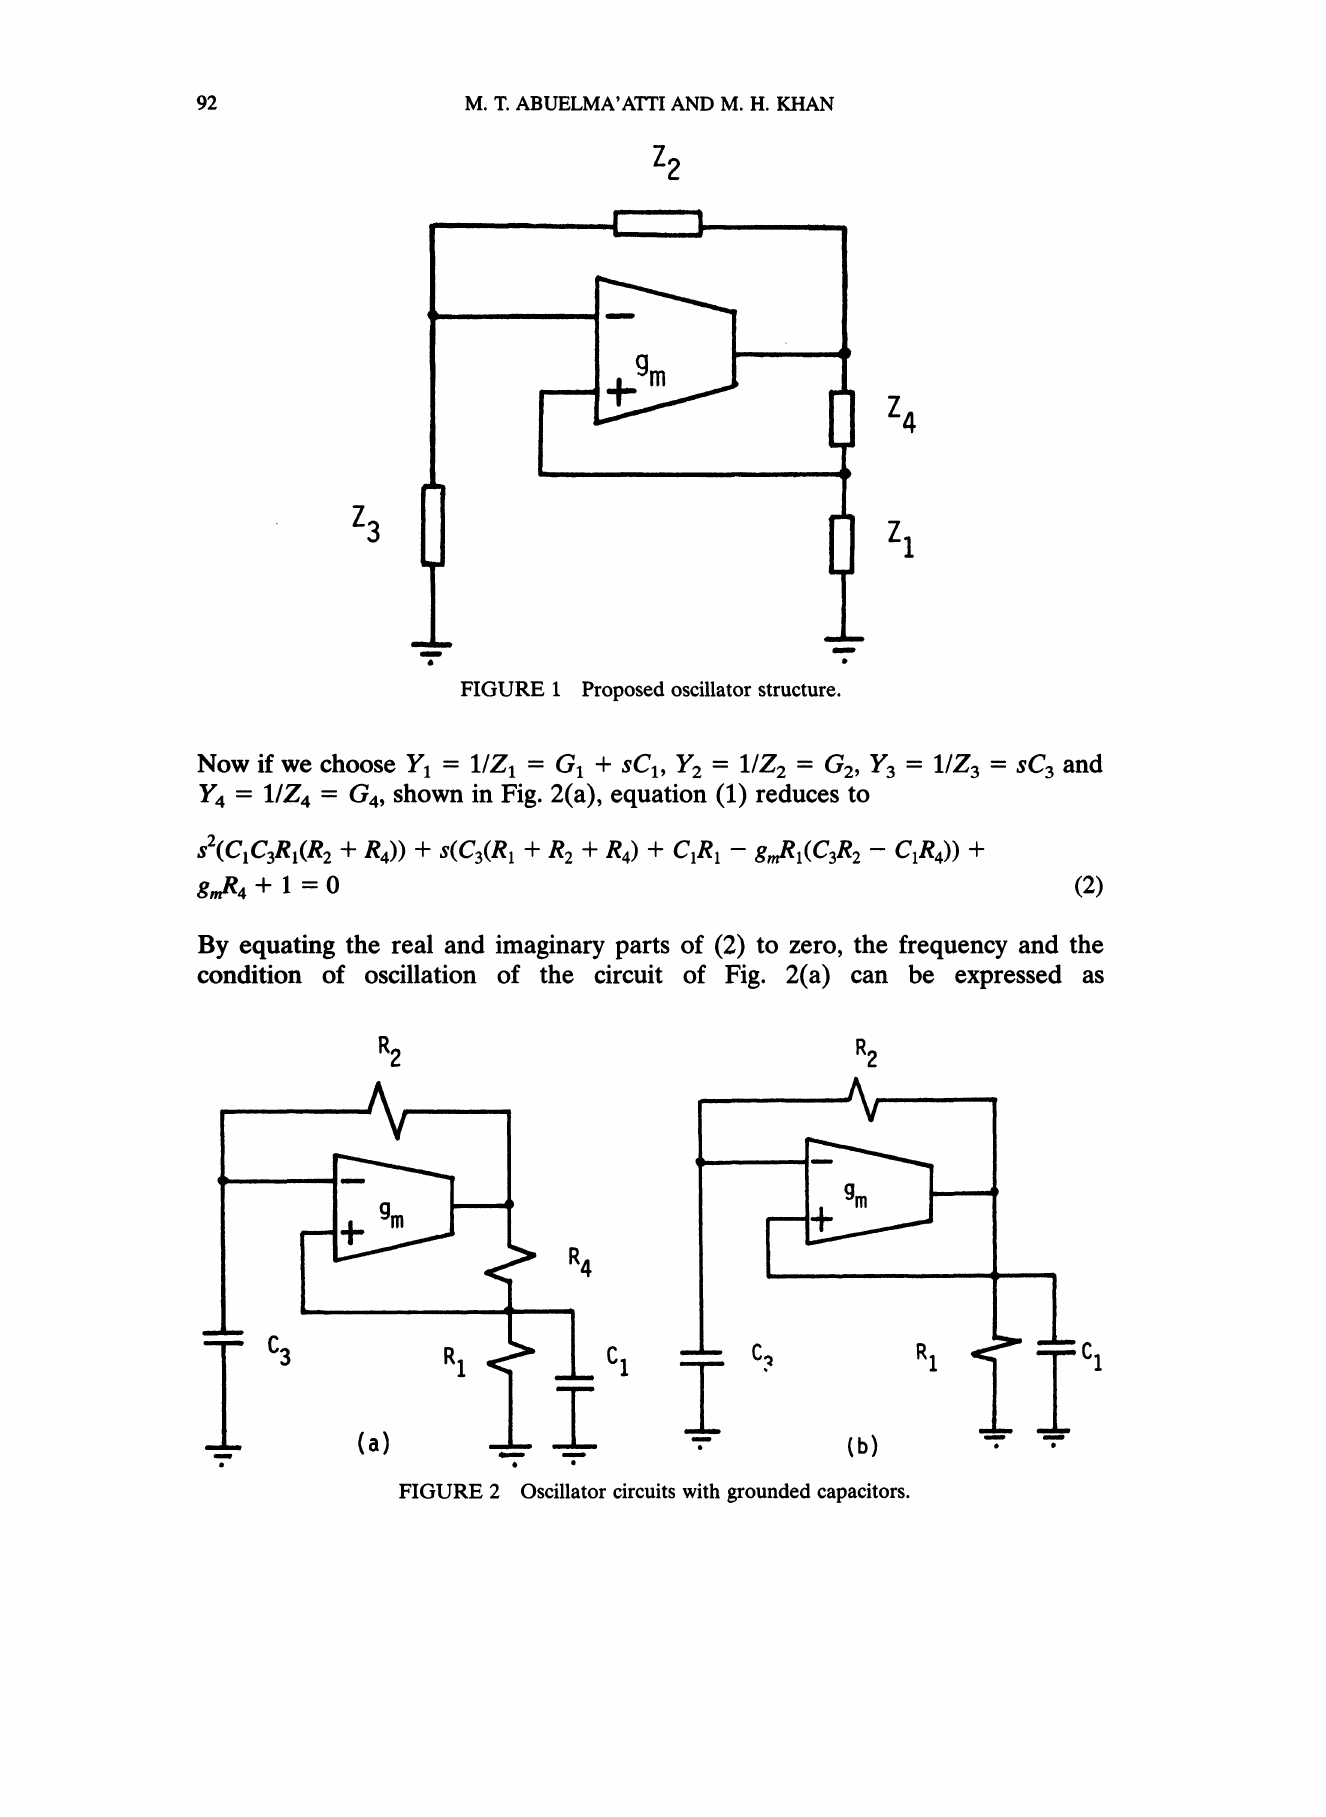
FIGURE 2 Oscillator circuits with grounded